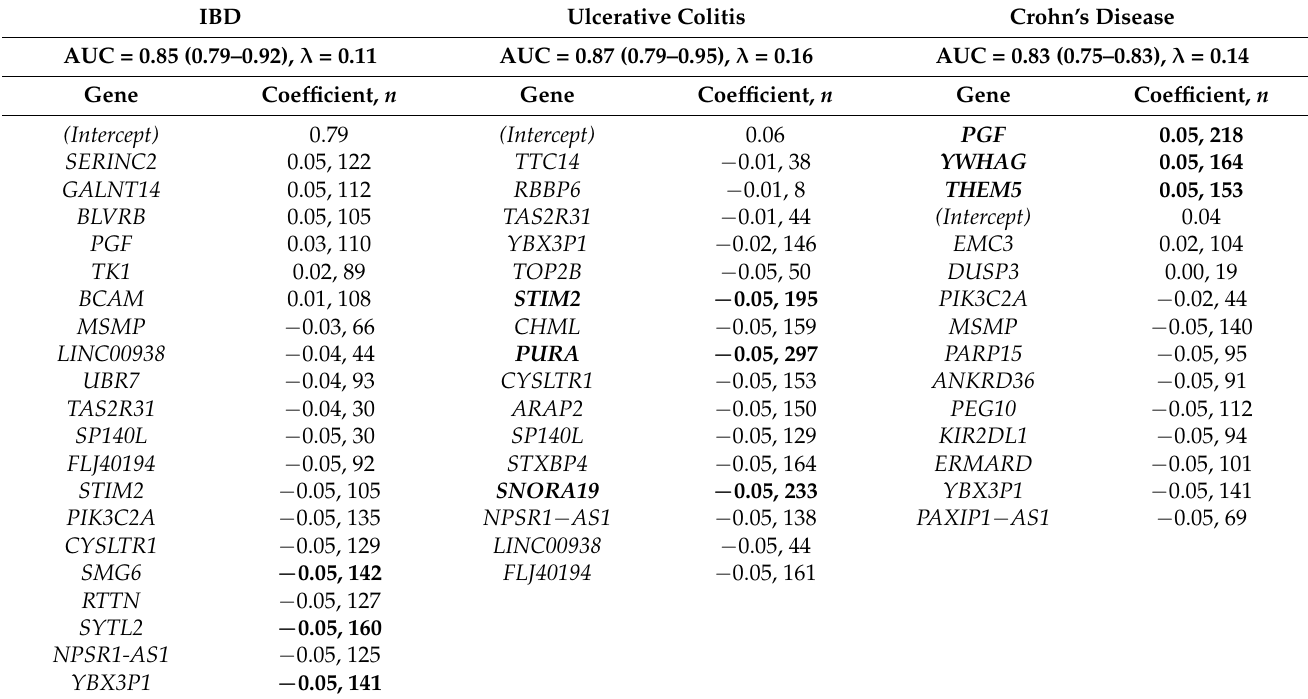
Table 1. Genes were selected by lasso regression to best discriminate patients with IBD from controls; both adults and children were included. Coefficients are presented together with the number of times the given transcript appeared in all tested model across the cross-validation/lambda grid (greater values indicate transcripts more systematically linked to IBD). The top three genes (highest n ) are indicated in bold. The area under the curve (AUC; 90% confidence interval), lambda shrinkage parameter, and the intercept for each model are also presented. Please note that the genes with the most discriminatory power are present at the top and the bottom of the